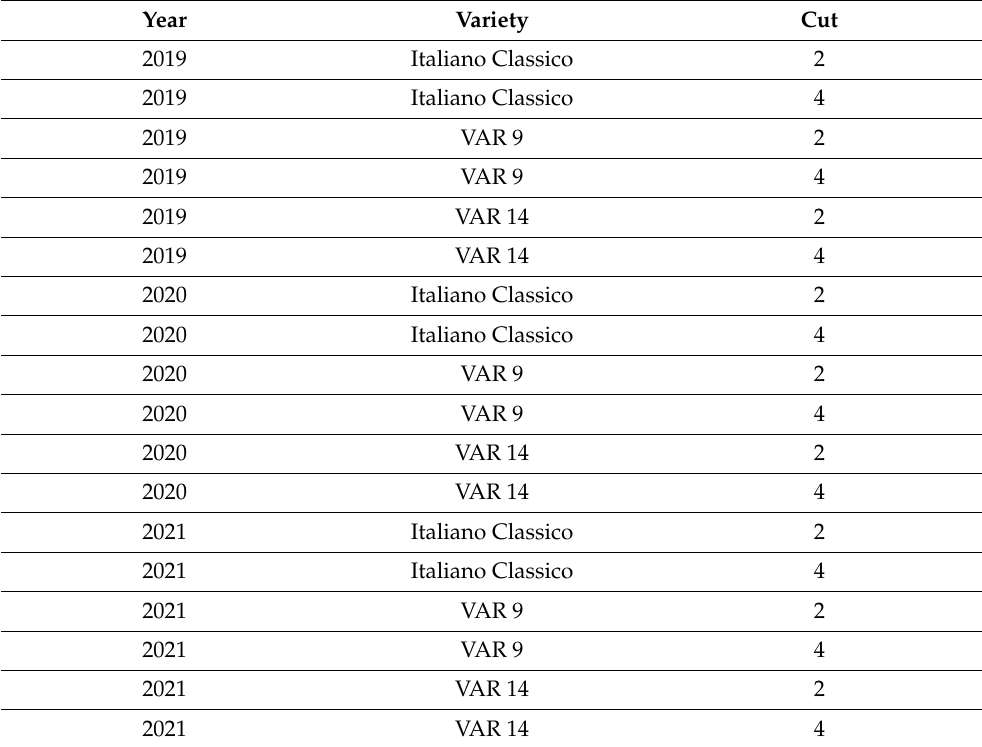
Table 2. Structure of the experimental design for ASCA for the years 2019, 2020 and 2021. Variety